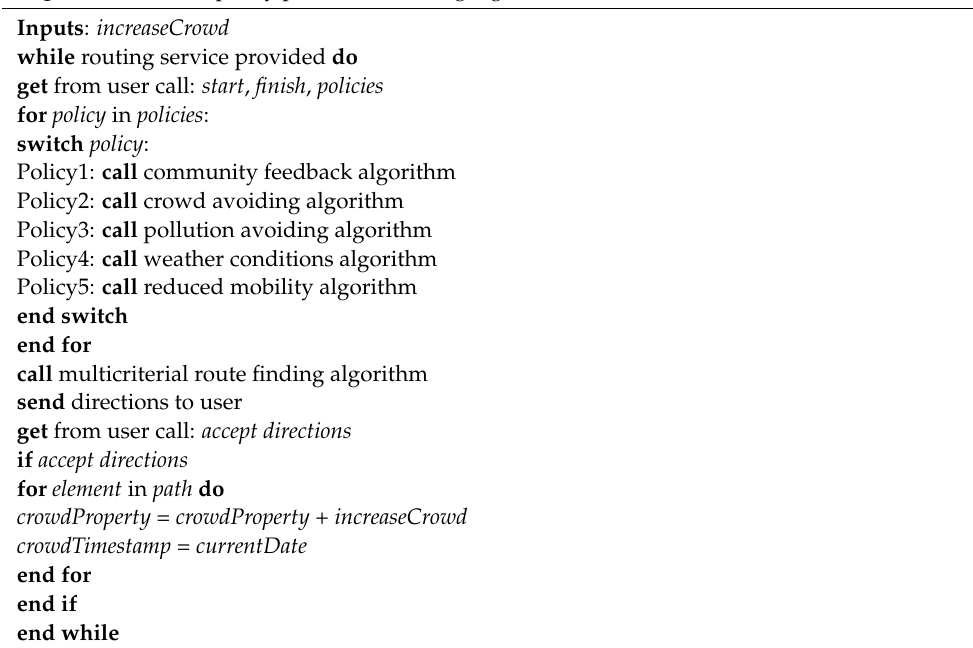
Algorithm 1. Multi-policy pedestrian routing